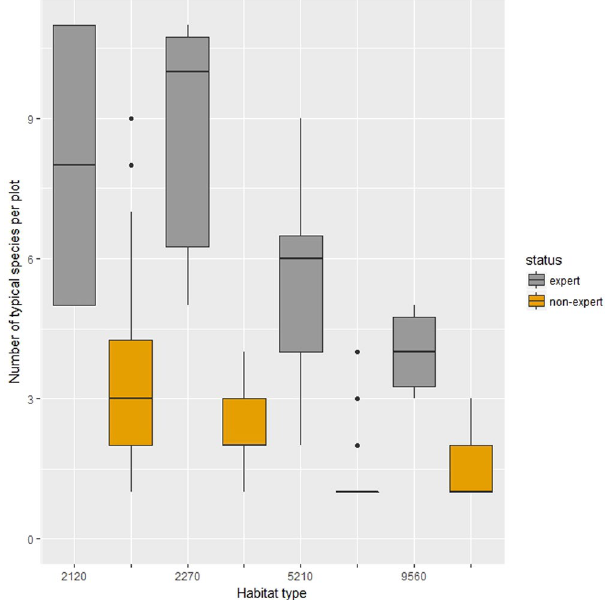
Figure 2. Boxplots of the number of typical species recorded per 100 m 2 sampling area for the different habitat types. With grey colour is the records made by experts and with orange colour is the records made by non- experts. Habitat codes, box and whiskers as in Fig.